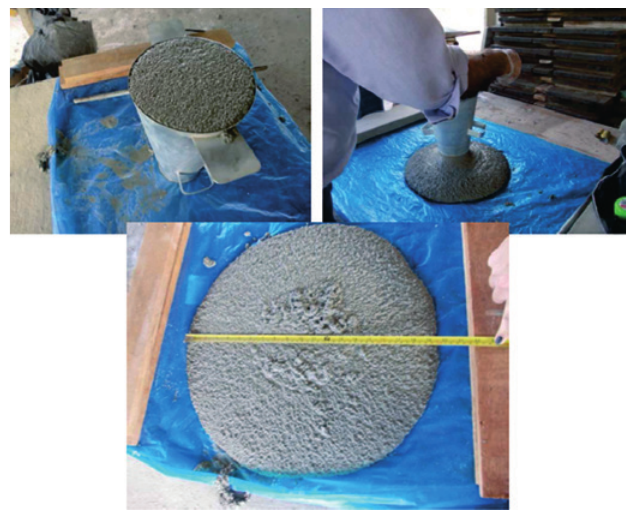
Figure 1 Slump flow test of SLCEB From: Catoia [2], p.